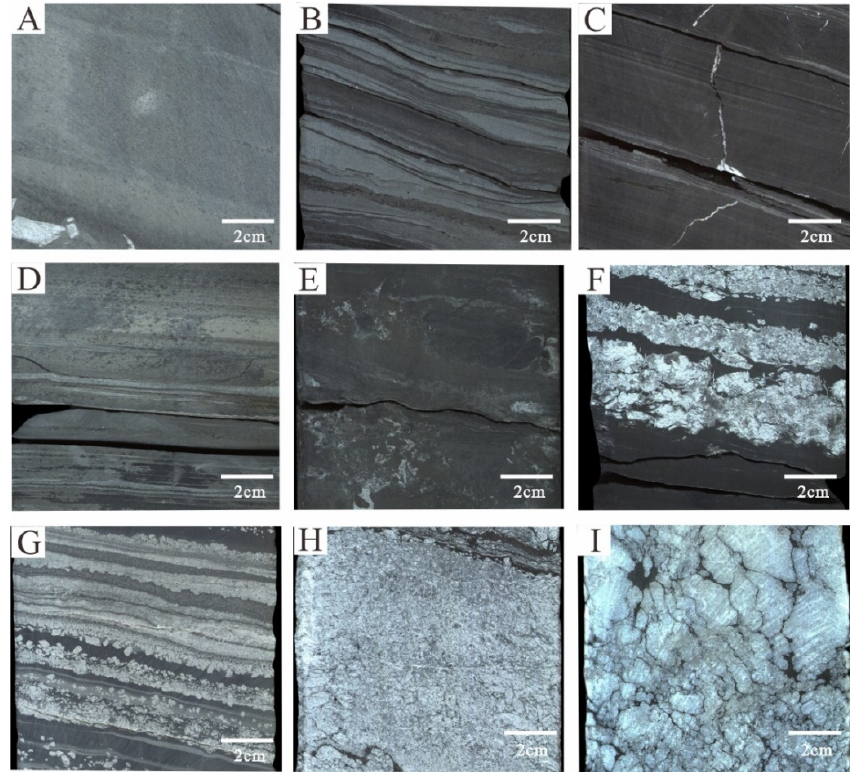
Figure 3. Main lithofacies characteristics of the lower member of Xingouzui Formation ( A )